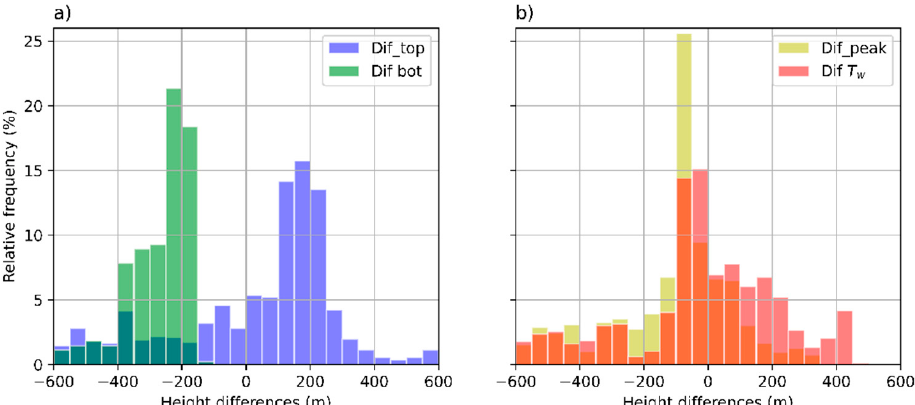
Figure 13. ( a ). Histograms of the differences between Bright Band top and Bright Band bottom heights and the sounding-derived freezing levels Diff_top (blue) and Diff_bot (green), respectively, and ( b ). histograms of differences between Bright Band peak height and the sounding-derived height of zero wet-bulb temperature, Diff_T w (red) and differences between Bright Band peak height and the freezing level, Diff_peak (yellow). Values are analysed around ±1.5 h from the sounding launch time.